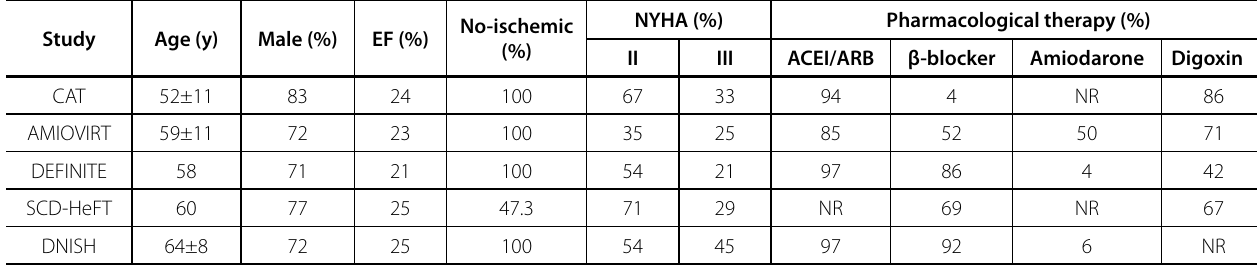
Table 2. Baseline clinical characteristics of patients.